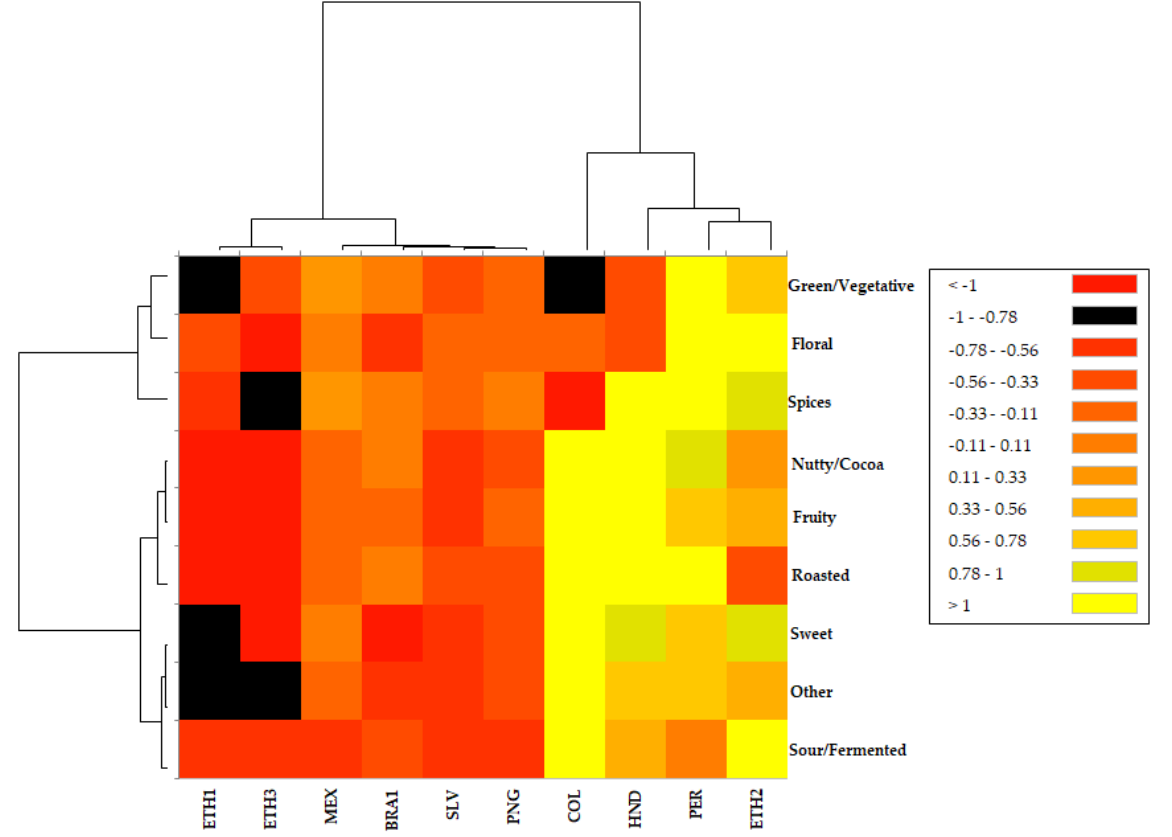
Figure 2. Hierarchical Cluster Analysis Heatmap (HCA Heatmap) of the volatile categories characterizing roasted coffee samples. The color of each tile of the Heatmap indicates the type/strength of the correlation for a given aroma category/sample combination. The yellow color indicates major abundance, while the red color indicates minor abundance.